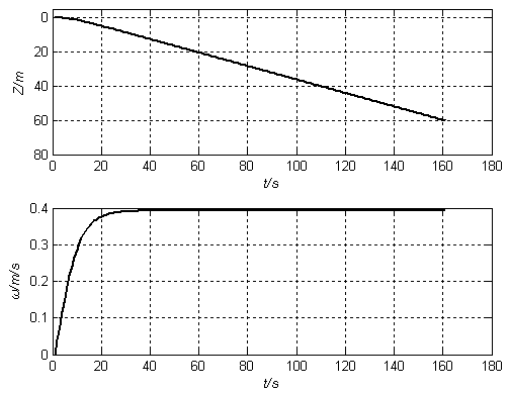
Figure 7. Simulation result of lateral movement.